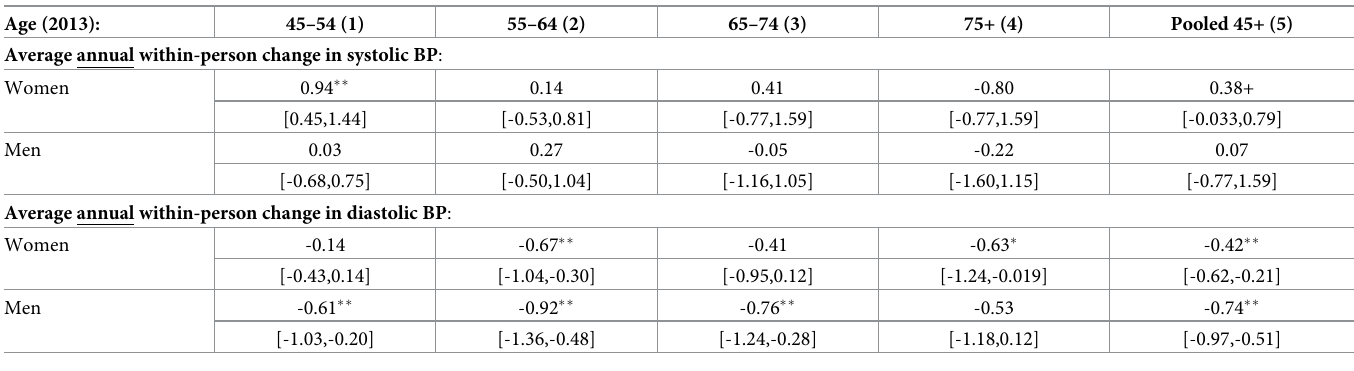
Table 3. Average annual within-person change in blood pressure during 2013–17, by 2017 age group.